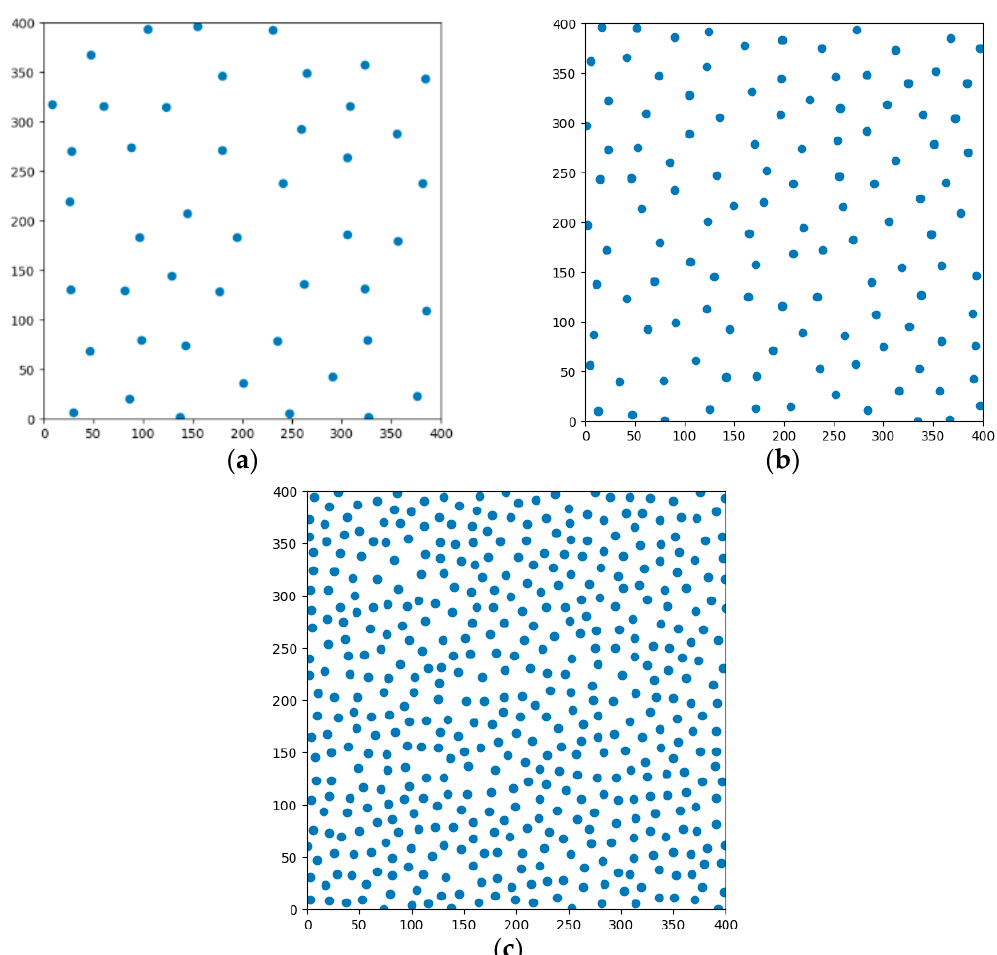
Figure 2. Poisson disk sampling. ( a ) 10% fill density; ( b ) 40% fill density; ( c ) 80% fill density.